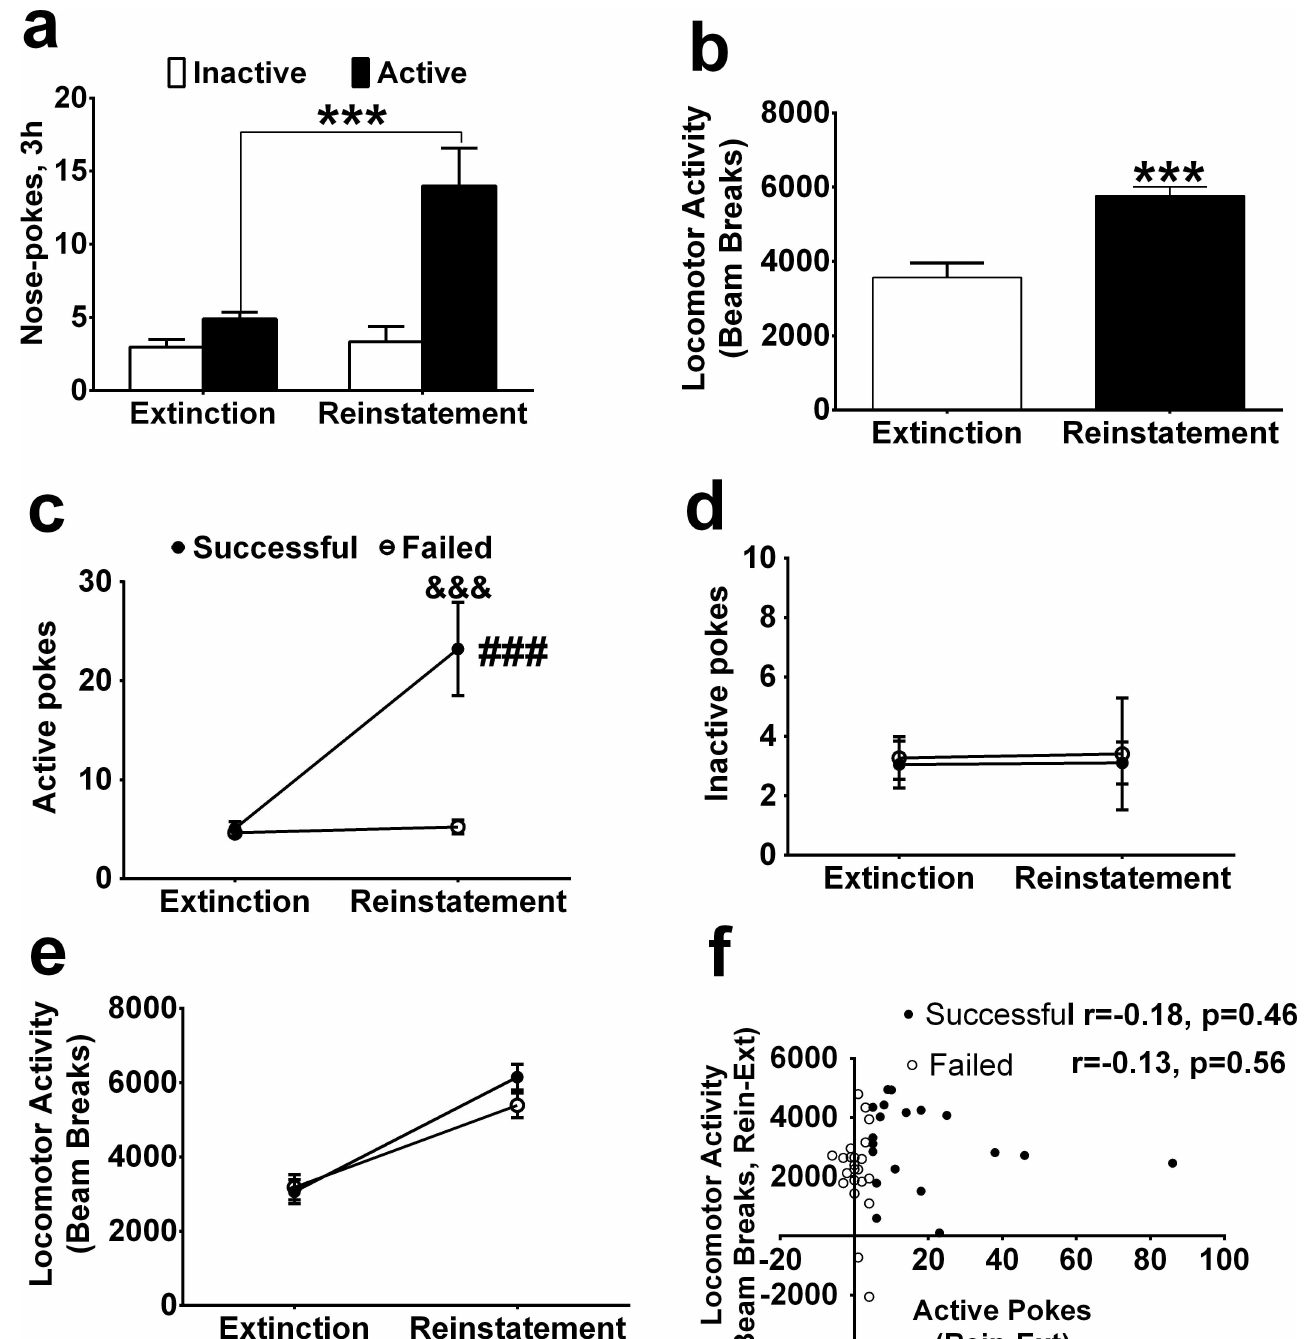
Fig 5. Morphine-primed reinstatement resulted in increaseof locomotor activity. (a) Morphineinducedreinstatement of drug-seekingbehavior (n = 41). (b) Locomotor activity increasedin the reinstatement test when comparedto the last extinctionday. (c) The active pokes in the successful reinstatement group (n = 20) were higherthan in the failed reinstatement group on the reinstatement test (n = 21). (d) There was no difference in the inactive pokes betweenthe successful reinstatement group and the failed instatement group. (e) Locomotoractivity increasedin the reinstatement test for both the successful reinstatement group and the failed reinstatement group. (f) The increase in locomotoractivity was not correlated with the increasein active pokes in the successful reinstatement group or the failed reinstatement group. *** p < 0.001, comparedto the last extinction session. ### p < 0.001, comparedto the failed reinstatement group. &&& p < 0.001, post hoc test comparedto the failed reinstatement group on the same session.